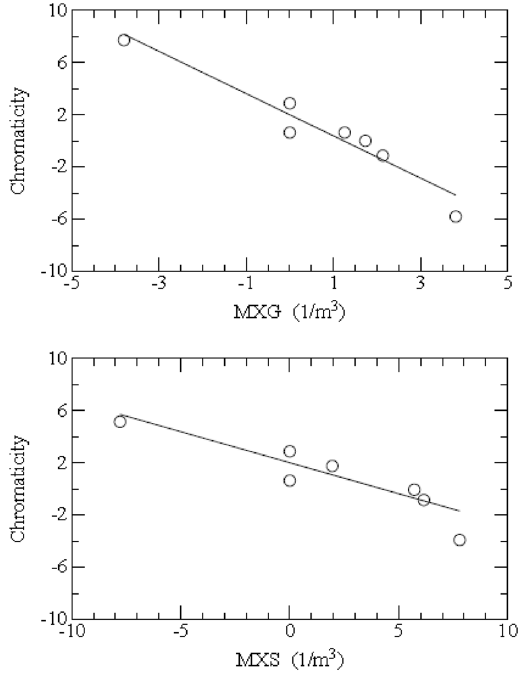
FIG. 5. Measurements of the y chromaticity in a manner similar to Fig. 1.